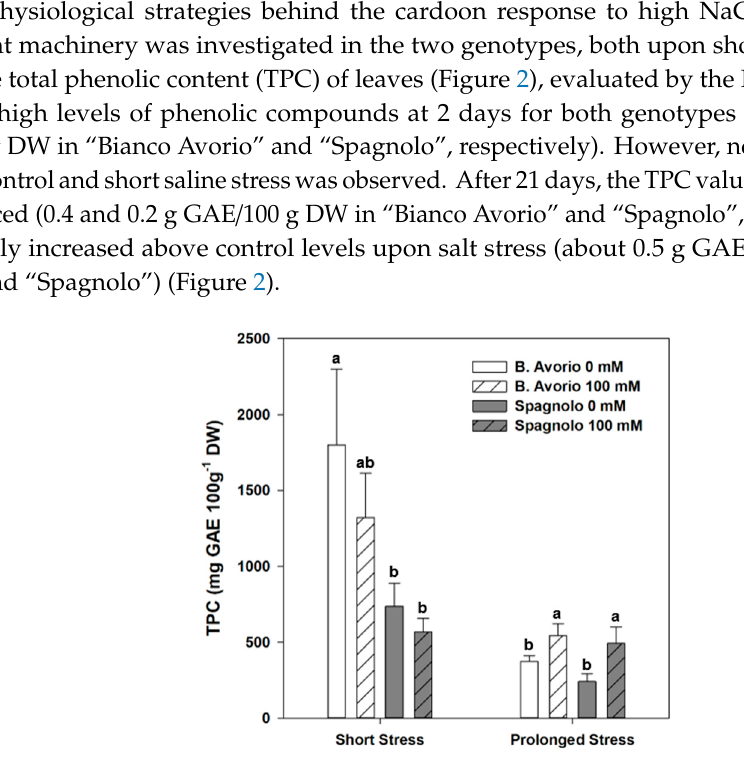
5 of 19 Figure 1. Levels of abscisic acid (ABA) in ( a ) roots and ( b ) leaves of “Bianco Avorio” and “Spagnolo”